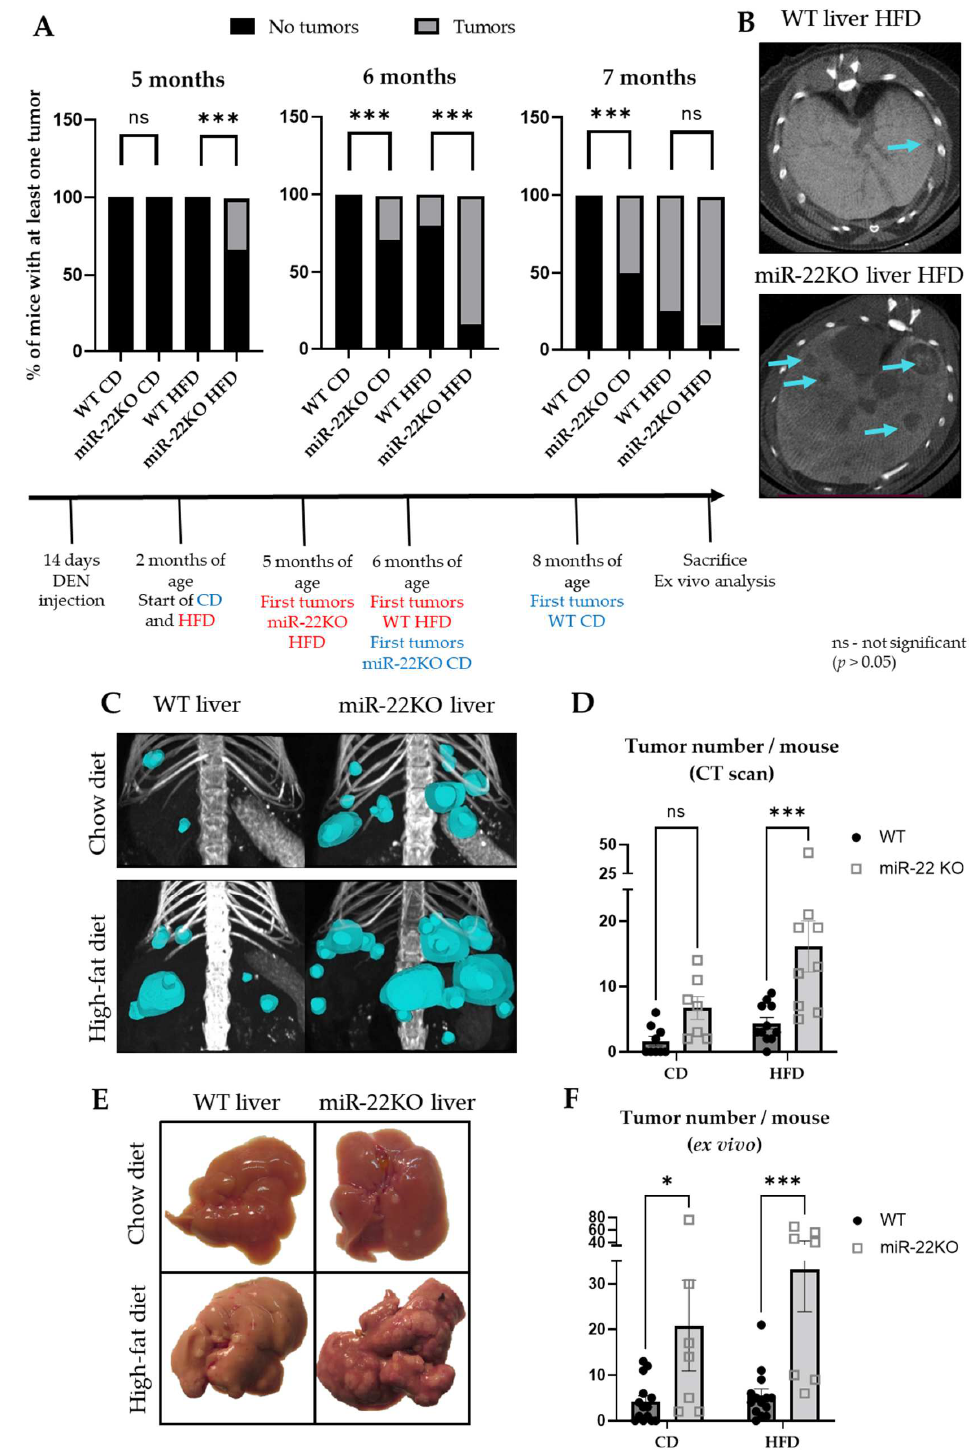
Figure 2. Initiation and progression of hepatocarcinogenesis in miR-22KO and WT mice. ( A ) CT-scan assessment of hepatic tumor incidence over time; graphs represent the percentage of WT and miR-22KO mice under chow diet (CD) or high-fat diet (HFD) bearing at least one tumor at 5, 6, or 7 months of age ( n = 3–6 mice/group). ( B ) Representative images of liver/tumor sections of WT and miR-22KO mice at 6 months of age (axial view, CT-scan imaging). Tumors are indicated with blue arrows. ( C ) 3D representative images of the tumors (blue) and ( D ) number of tumors per mouse detected during CT- scan analysis in WT and miR-22KO mice under CD or HFD at 11 months of age ( n = 7–11